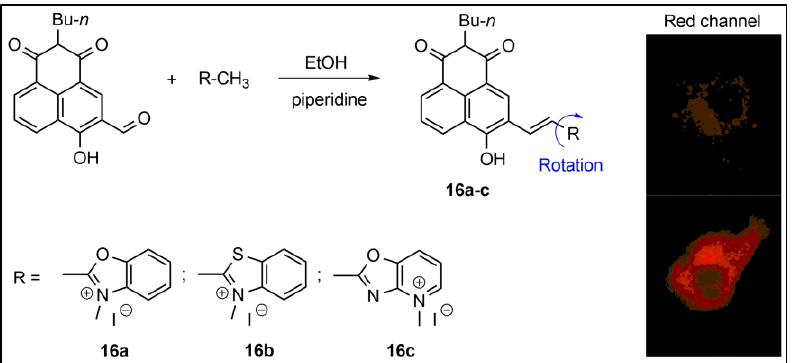
Figure 17. Synthetic routes of probes 16a-c . Confocal laser fluorescence images of probe 16a in HeLa cells. Cells incubated with the probe (10 µ M) for 20 min (upper panel) and incubated with monensin (10 µ M) for 30 min and probe 16a (10 µ M) for another 20 min (lower panel). Adapted with permission from [82]. Copyright (2021)